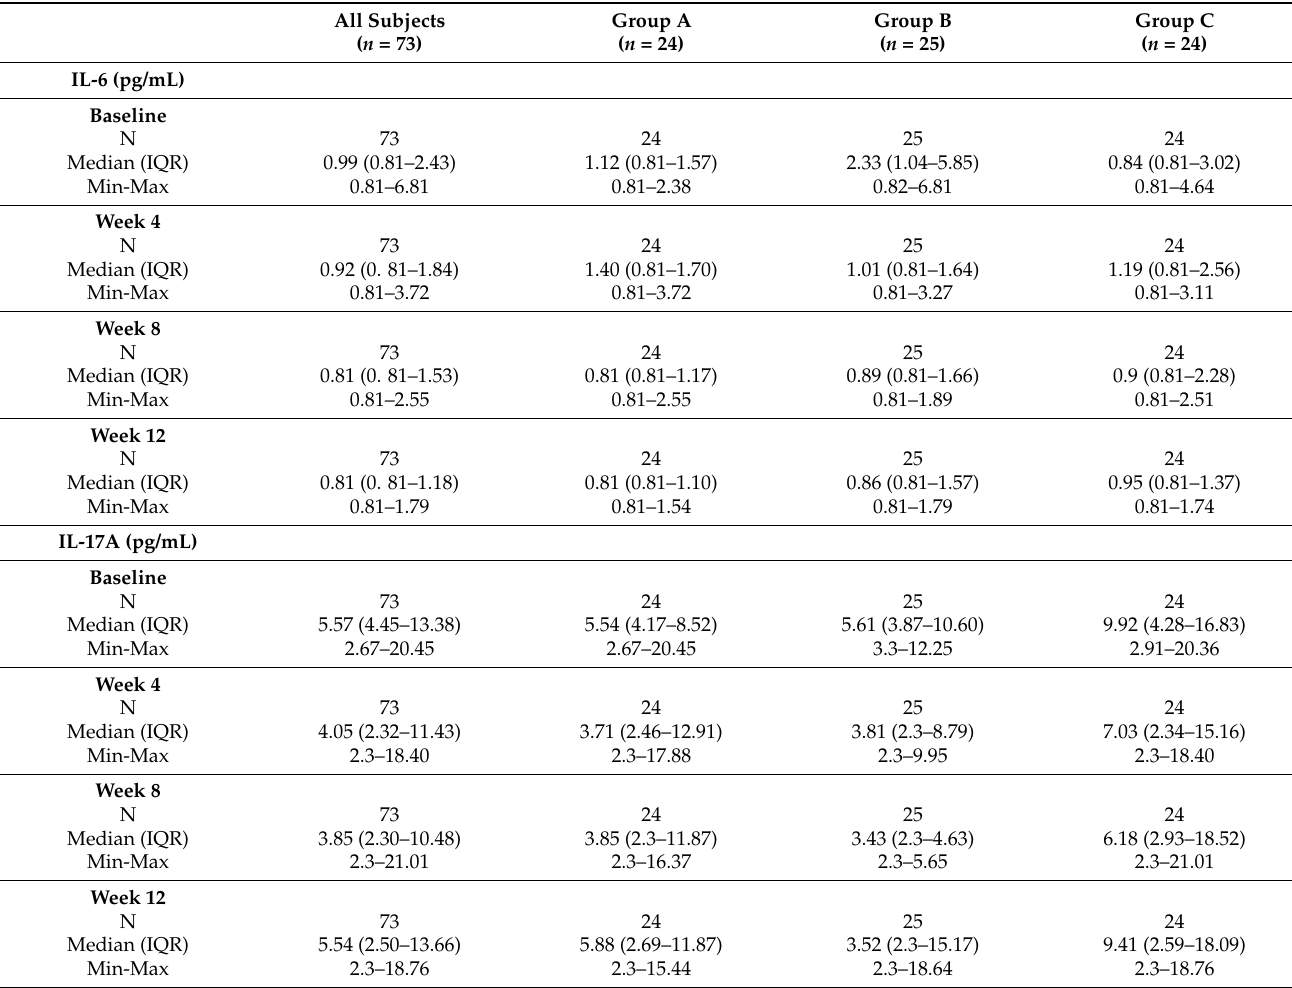
Table 2. Serum cytokines concentrations at baseline. No statistical differences were observed among